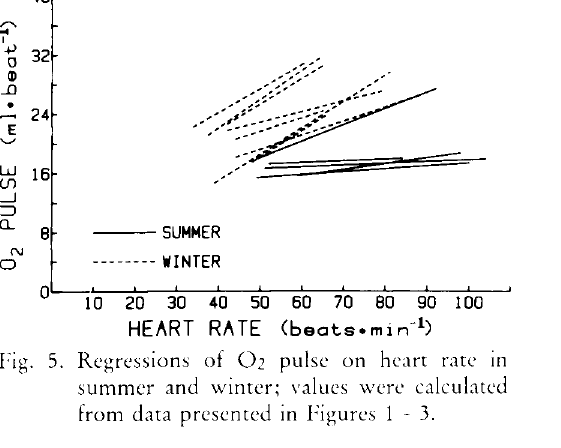
Fig. 5. Regressions of O2 pulse on heart rate in summer and winter; values were calculated from data presented in Figures 1 -